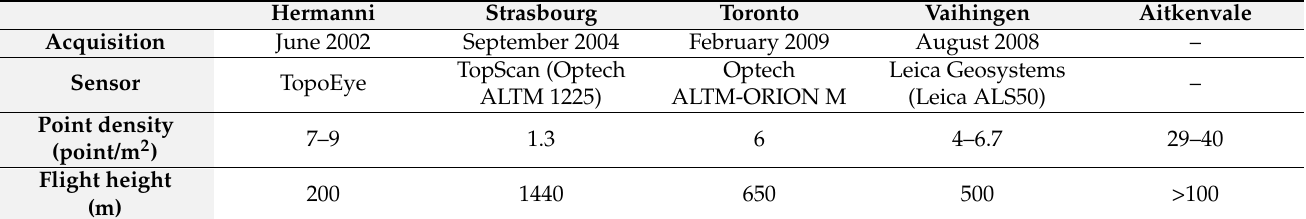
Table 2. Tested datasets.